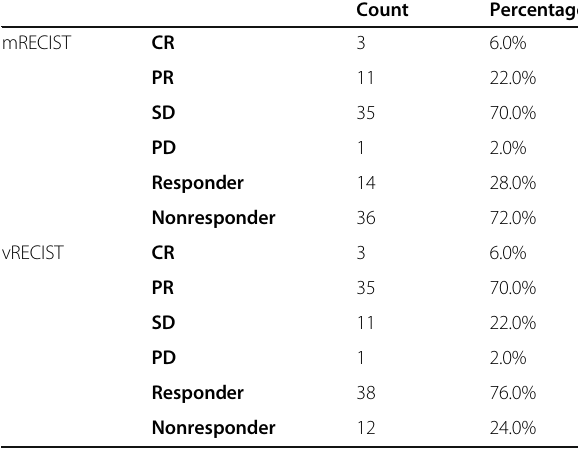
Table 3 Classification of lesions according to their